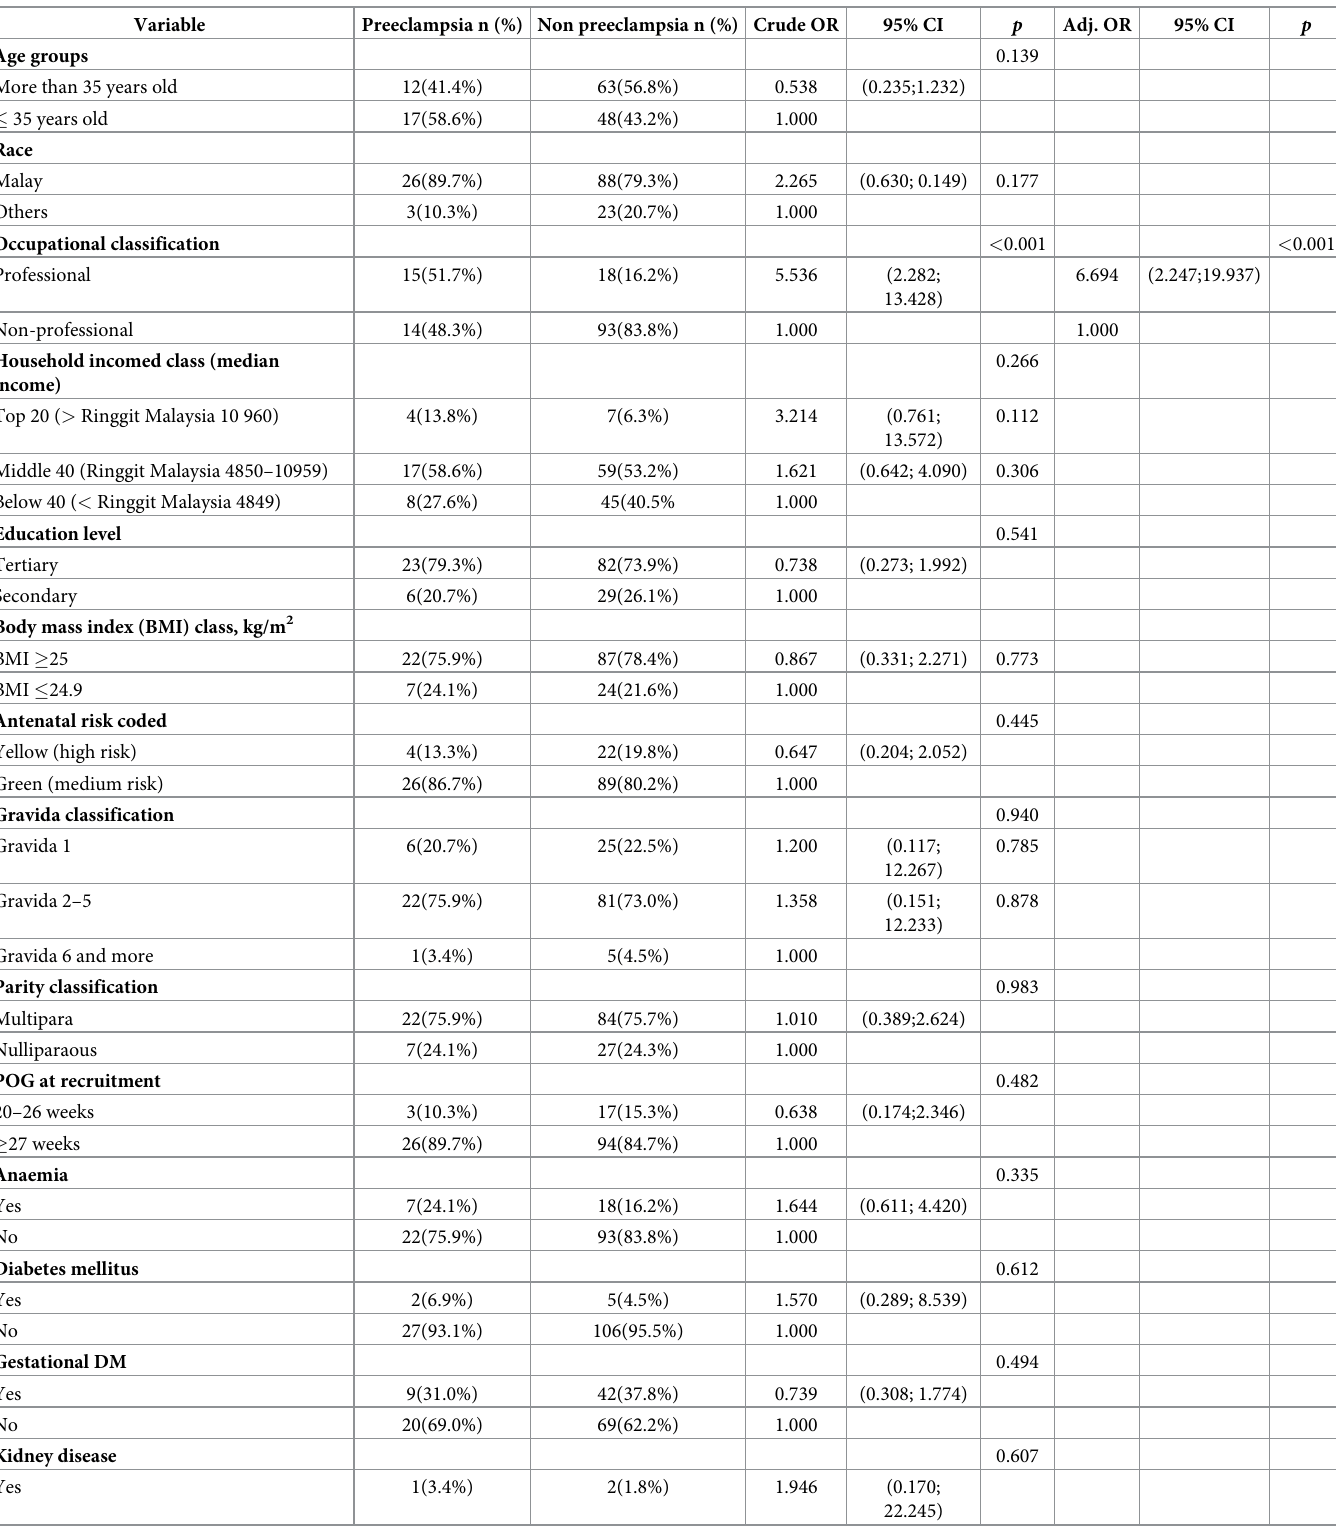
Table 2. Factors associated with